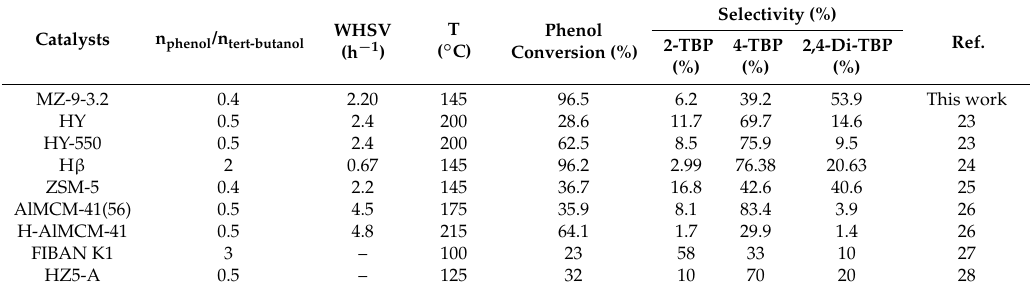
Table 3. The compared results of alkylation of phenol with tert-butanol on different catalysts. Catalysts n phenol /n